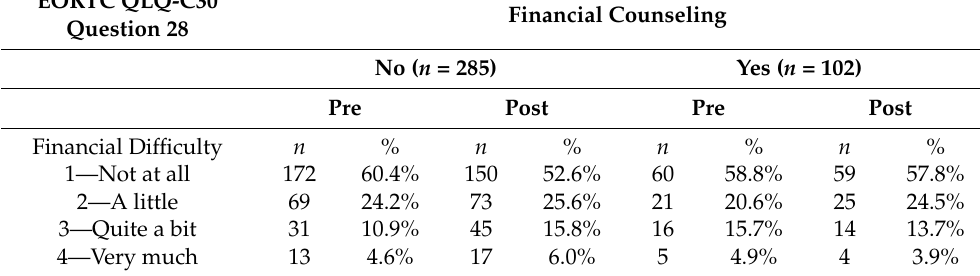
Table 2. Financial difficulty scores by receipt of financial counseling.